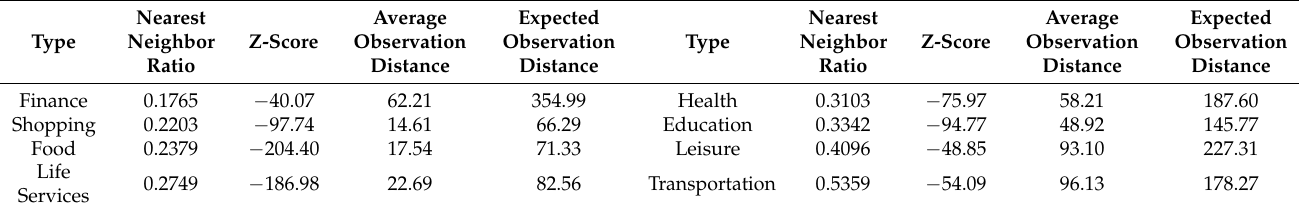
Table 3. The score of average nearest